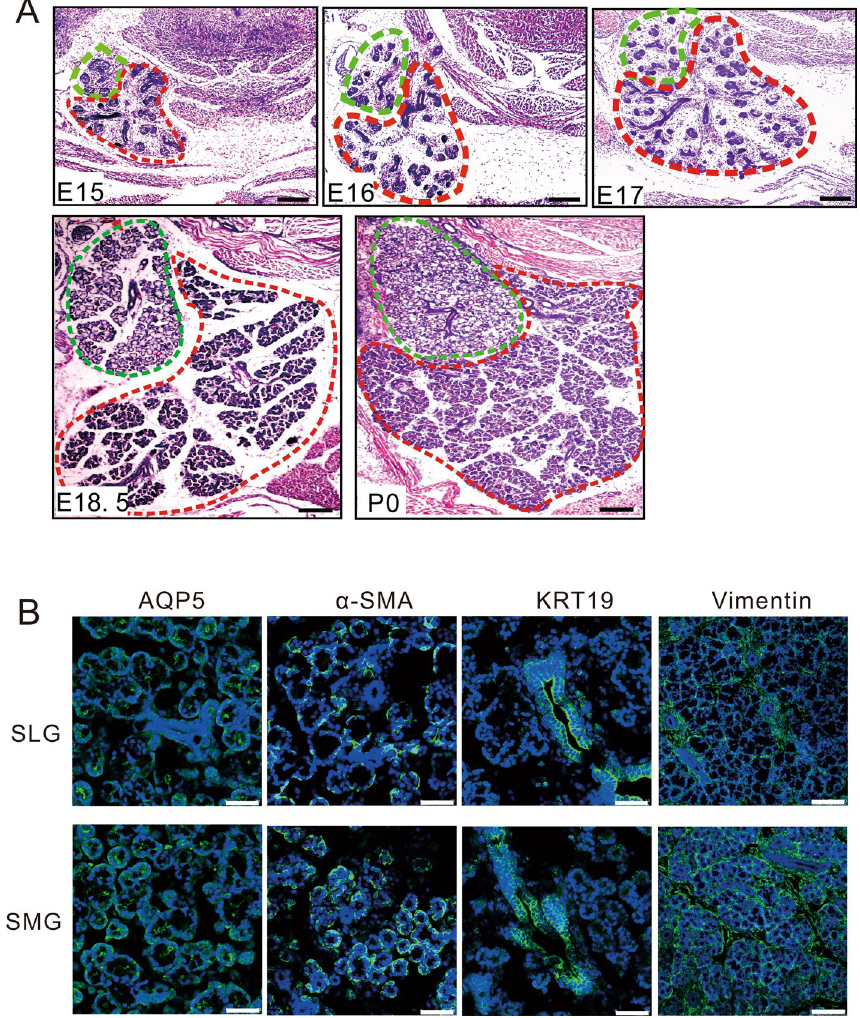
Fig. 1 Morphology and marker expression in SMG and SLG. A H&E staining of a mouse embryonic submandibular gland (SMG, red dotted line) and sublingual gland (SLG, green dotted line) in the middle-late phase of development. Remarkably differentiated acinar cells are shown on E18.5, characterized by SMG with a majority of serous acinar cells and SLG with a majority of mucous acinar cells. B Salivary gland markers were detected by fluorescent staining. Aquaporin (AQP) 5 protein was localized in the cytomembrane of acinar cells. Smooth muscle α-actin (α-SMA) was revealed in the cytoplasm of myoepithelial cells and basal duct cells. Cytokeratin (KRT)19 was marked in luminal duct cells cytoplasm. Mesenchymal marker vimentin was expressed in mesenchymal cells and a few basal epithelial cells cytoplasm. Bar, 200